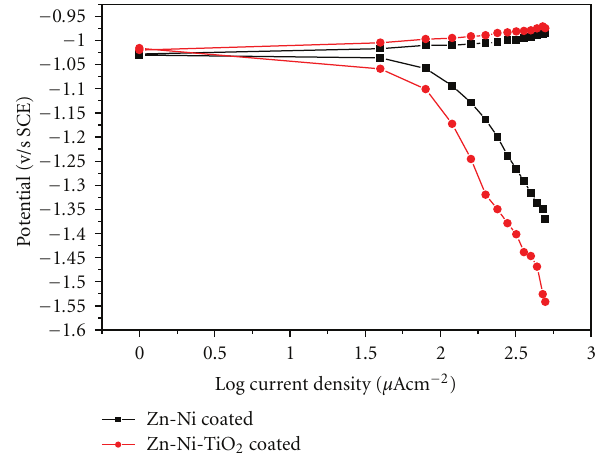
Figure 3: Tafel plots of composite-coated and alloy-coated samples.